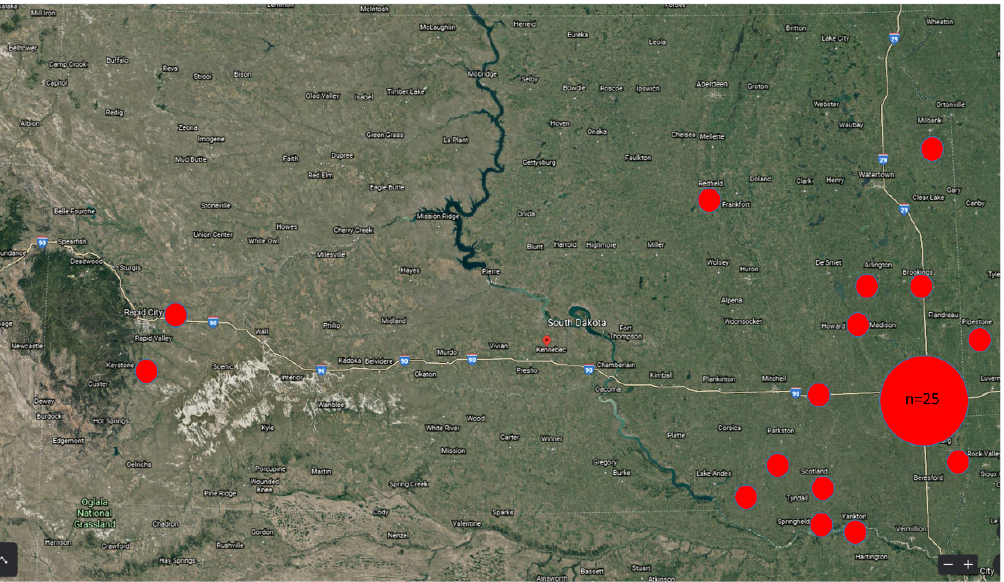
Figure 1. Map of bat collection sites. Each small red dot represents a single bat specimen. The large red dot represents 25 specimens. Map of South Dakota downloaded from Google Earth (www.google.com/earth).